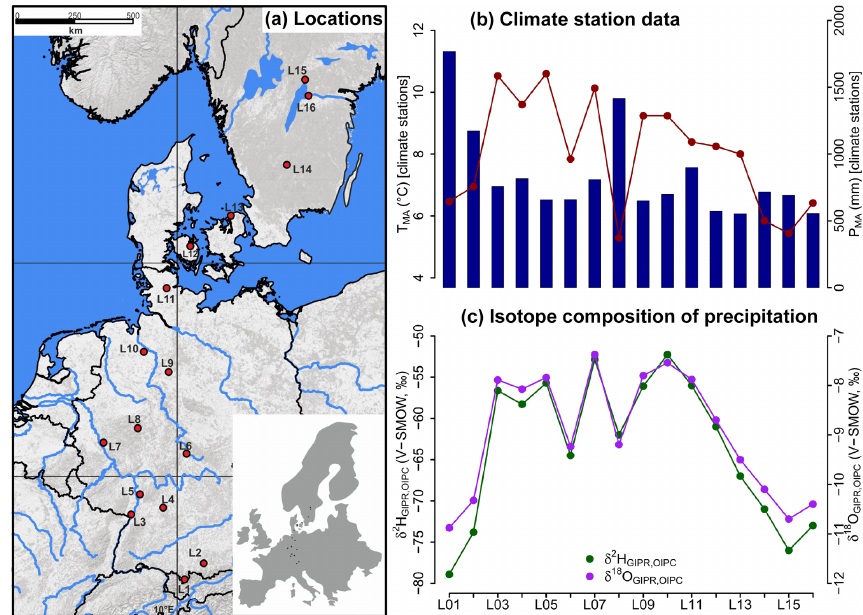
Figure 1. (a) Sample locations (red dots, map source: US National Park Service), (b) variations of mean annual air temperature ( T MA , red dots and line) and mean annual precipitation ( P MA , blue bars) derived from close-by climate station data, and (c) hydrogen and oxygen stable isotope composition of precipitation ( δ 2 H GIPR , OIPC and δ 18 O GIPR , OIPC , respectively) as derived for the sampled transect locations (see Sect. 2.2 GIPR δ 2 H and δ 18 O generation procedure). The reader is referred to Sect. 2.2 (and Tables S1 and S2) for database and reference information of data plotted in (b) and (c)